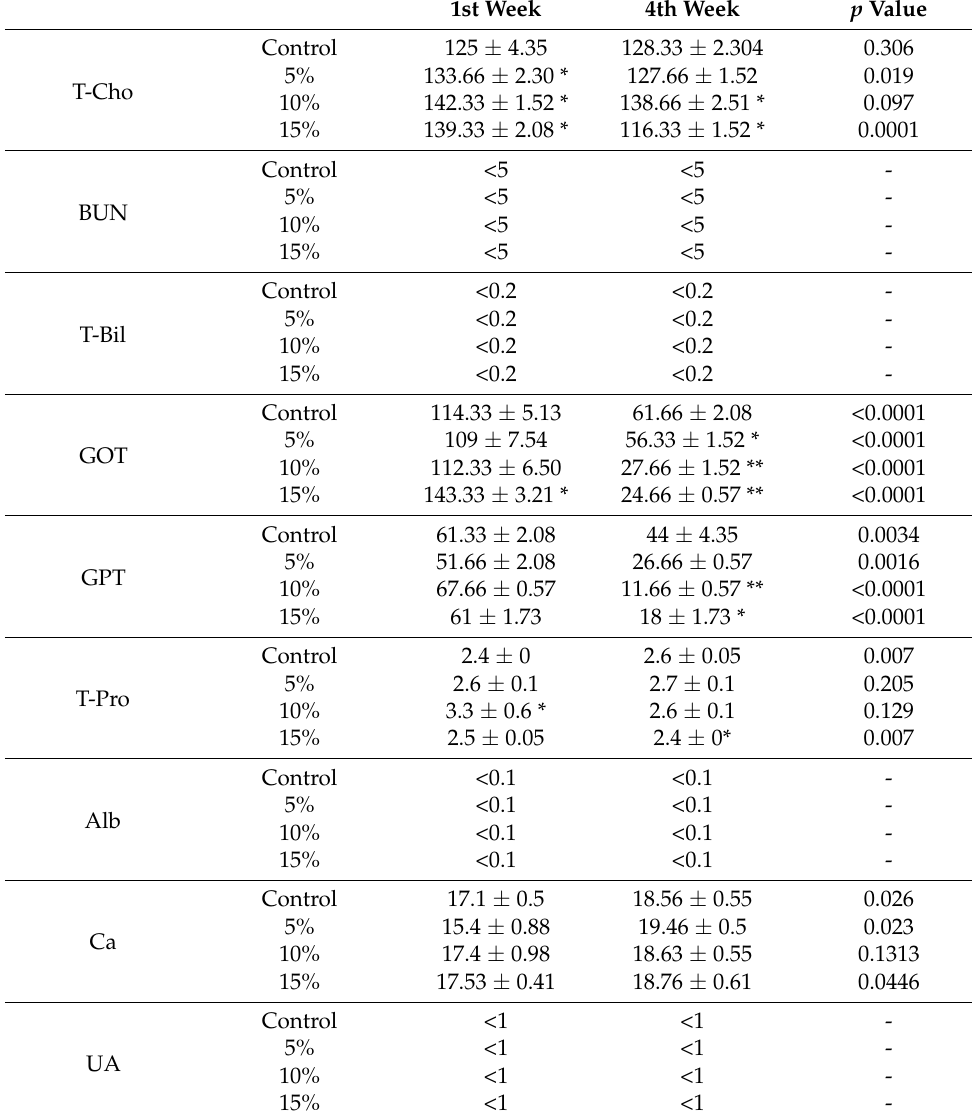
Table 1. Serum indices of Nile tilapia fed with acetyl-xylogalactan for 4